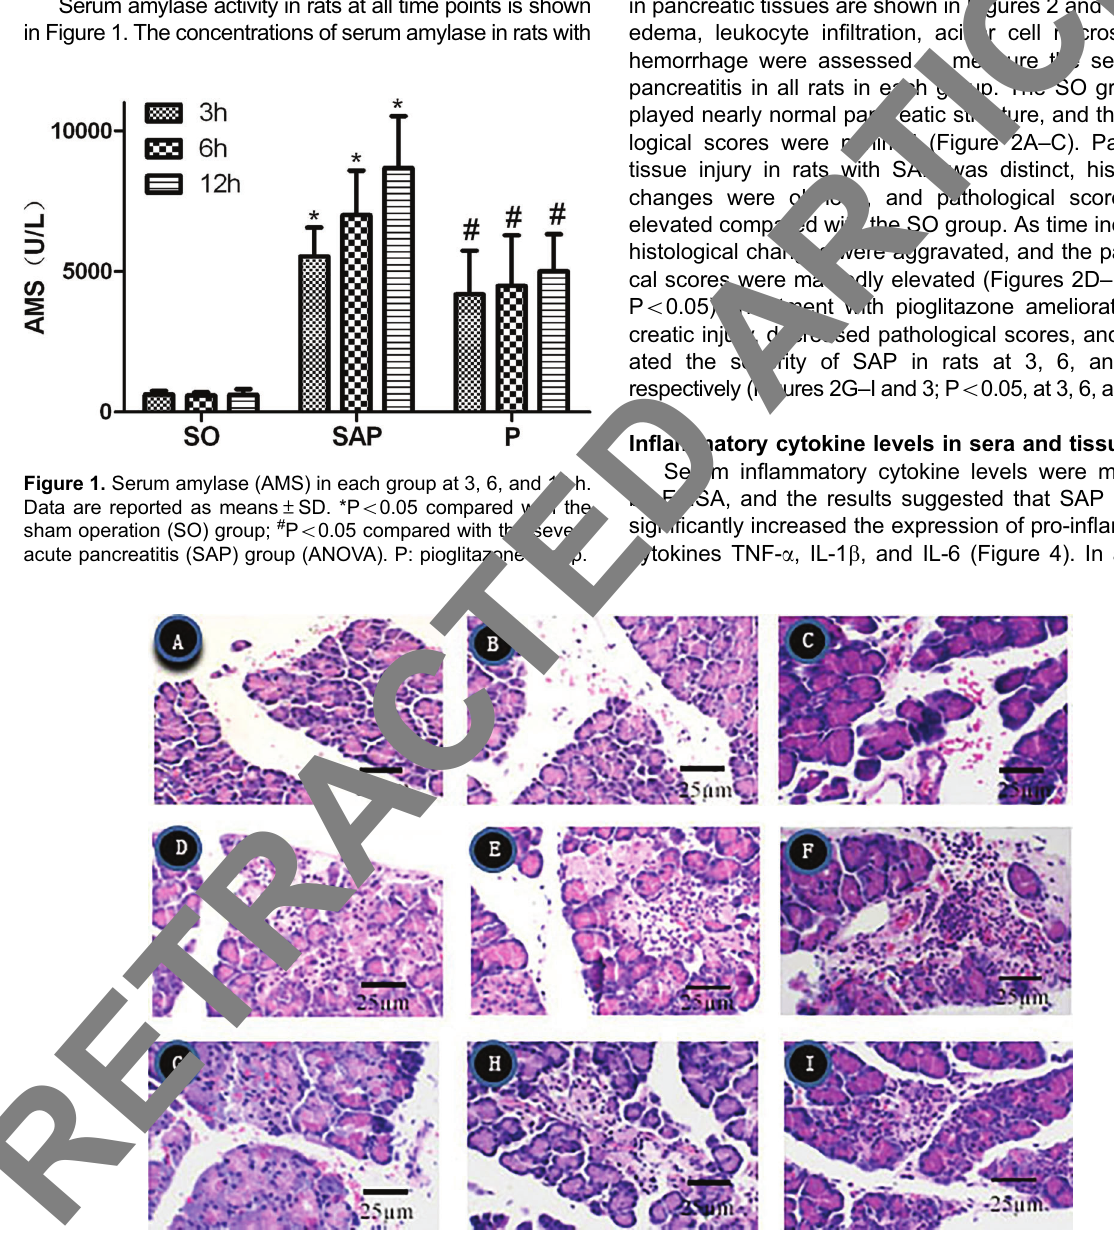
Figure 2. Histopathological examination of the pancreas (hematoxylin and eosin staining, original magni fi cation, (cid:2) 400). A , SO group, 3h; B , SO group, 6h; C , SO group, 12h; D , SAP group, 3h; E , SAP group, 6h; F , SAP group, 12h; G , Pi group, 3h; H , Pi group, 6h; I , Pi group, 12h. SO: sham operation group; SAP severe acute pancreatitis group, Pi: pioglitazone group.